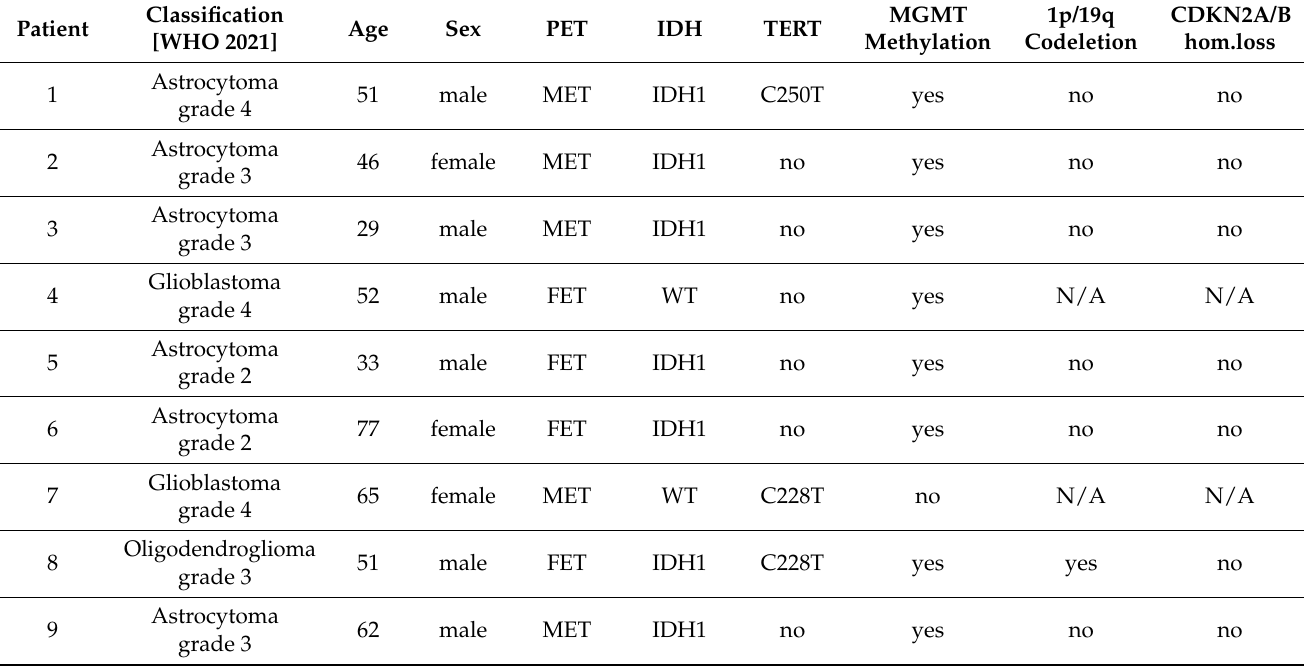
Table 1. Patient cohort